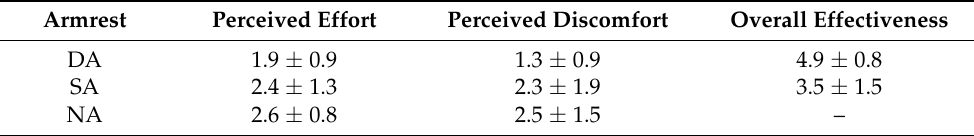
Table 8. Questionnaire data for each armrest condition (DA = dynamic armrest, SA = stationary armrest, and NA = no armrest), expressed as mean ± standard deviation (perceived effort and discomfort: 0 = none, 6 = tremendous; overall effectiveness: 0 = not effective, 6 =